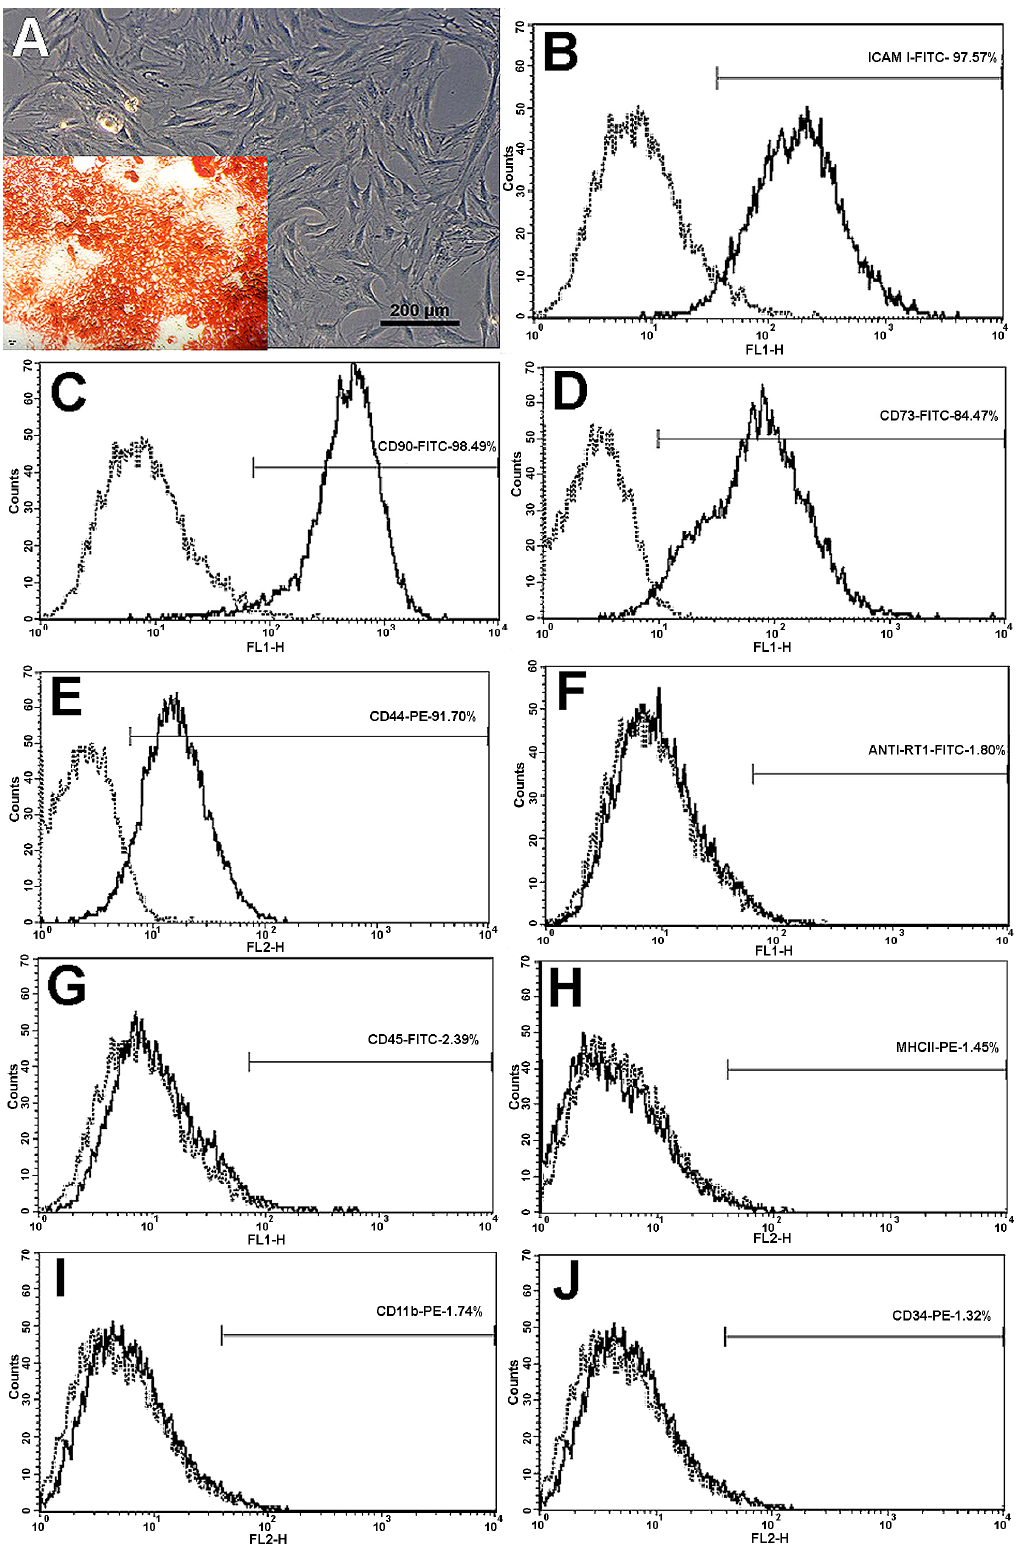
Figure 1. ( A ) Cultivated rat MSCs showing expected fibroblastoid (fusiform) shape. In detail: calcium deposits stained red in MSC cultures after 12 days of differentiation. (B) ICAM-I; (C) CD90; (D) CD73; (E) CD44; (F) anti-RT1; (G) CD45; (H) MHC II; (I) CD11b; (J) CD34.